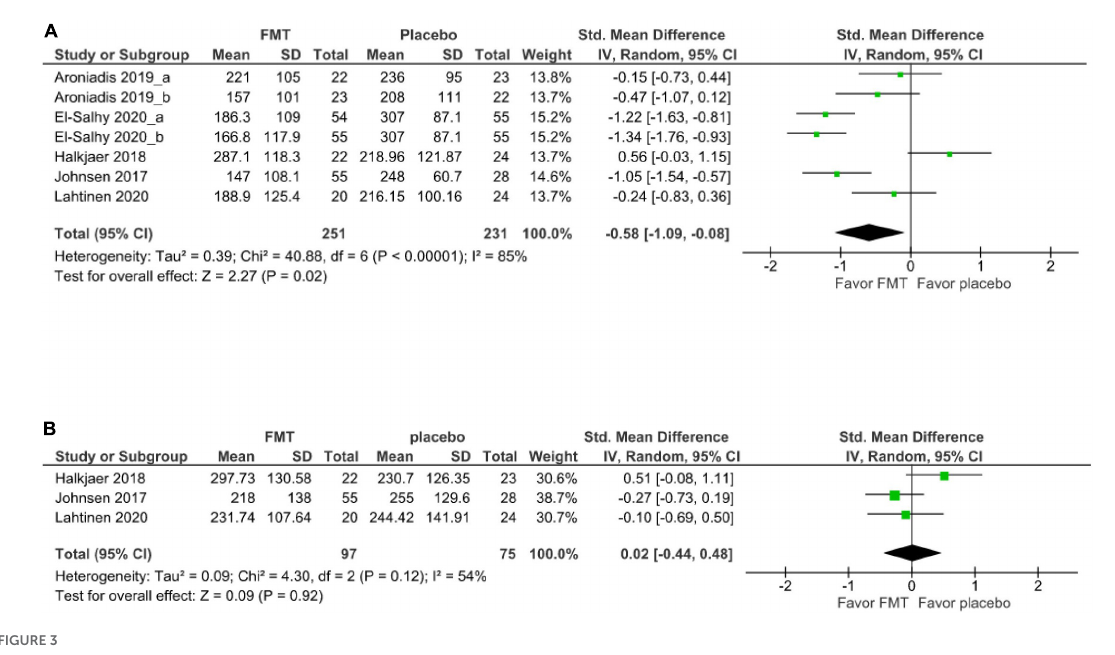
FIGURE3 Forest plot of IBS-SSS outcome between FMT and placebo. (A) Short term. (B) Long term.